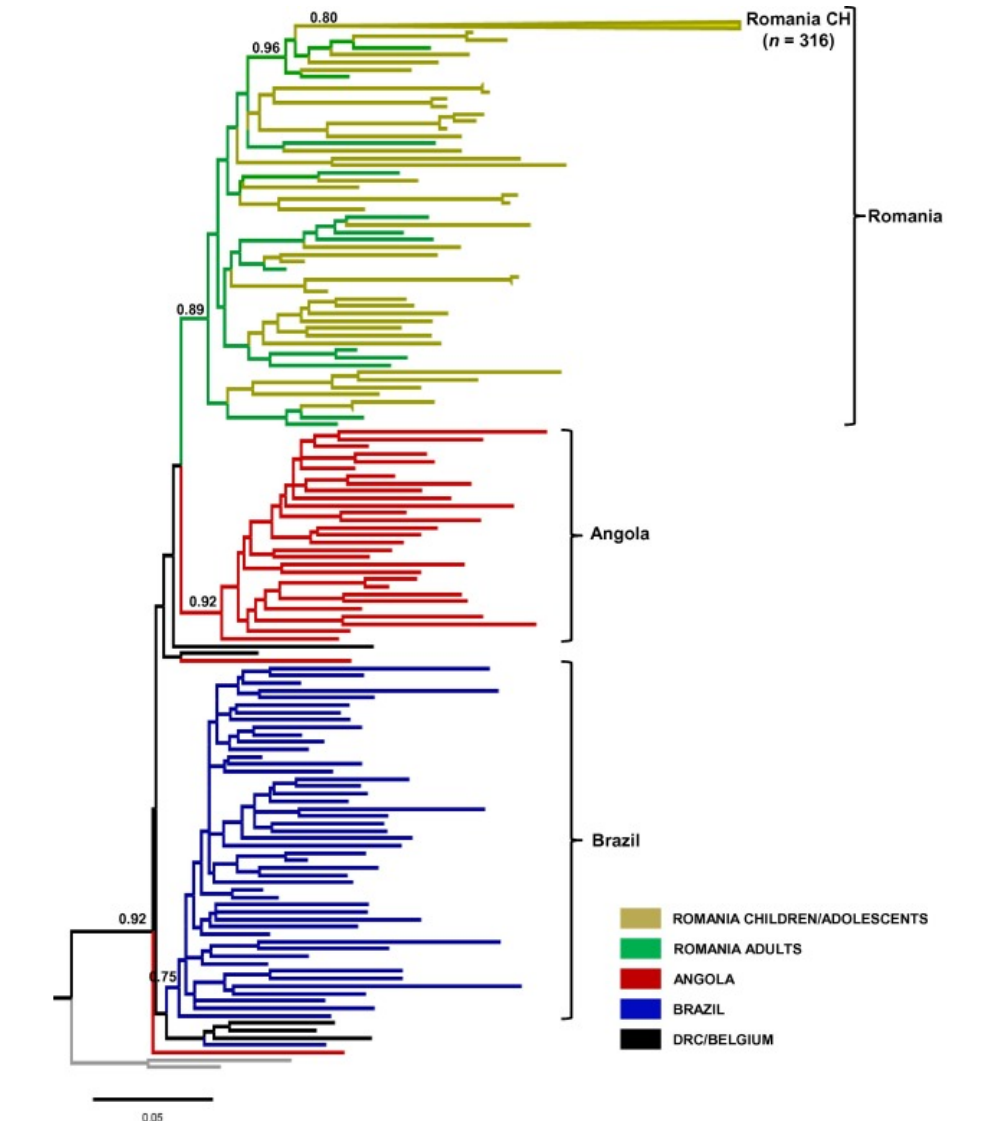
Figure 3. Phylogenetic analysis of the pol gene of HIV-1 subtype F1 strains circulating in Angola, Brazil, Romania, the DRC, and Belgium (linked to the DRC) (image source: [4]).